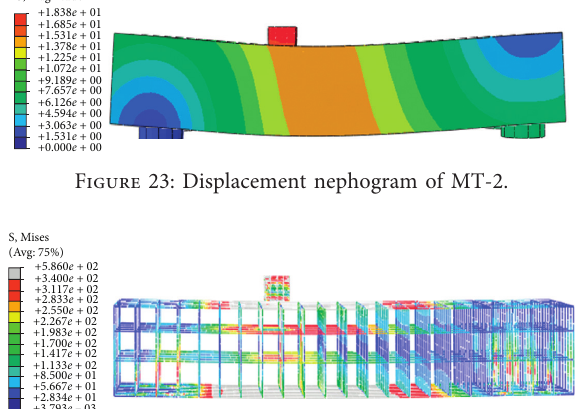
Figure 24: Steel bar stress nephogram of